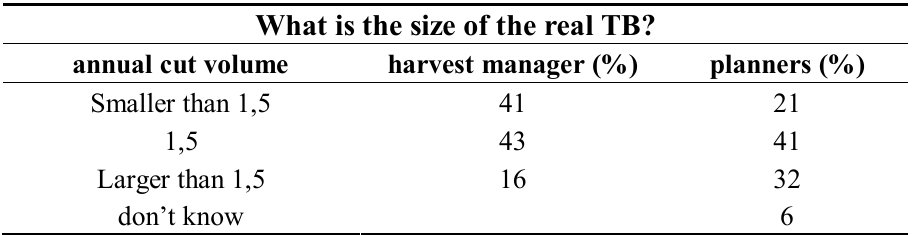
Table 2. The perceived size of the tract bank (TB).